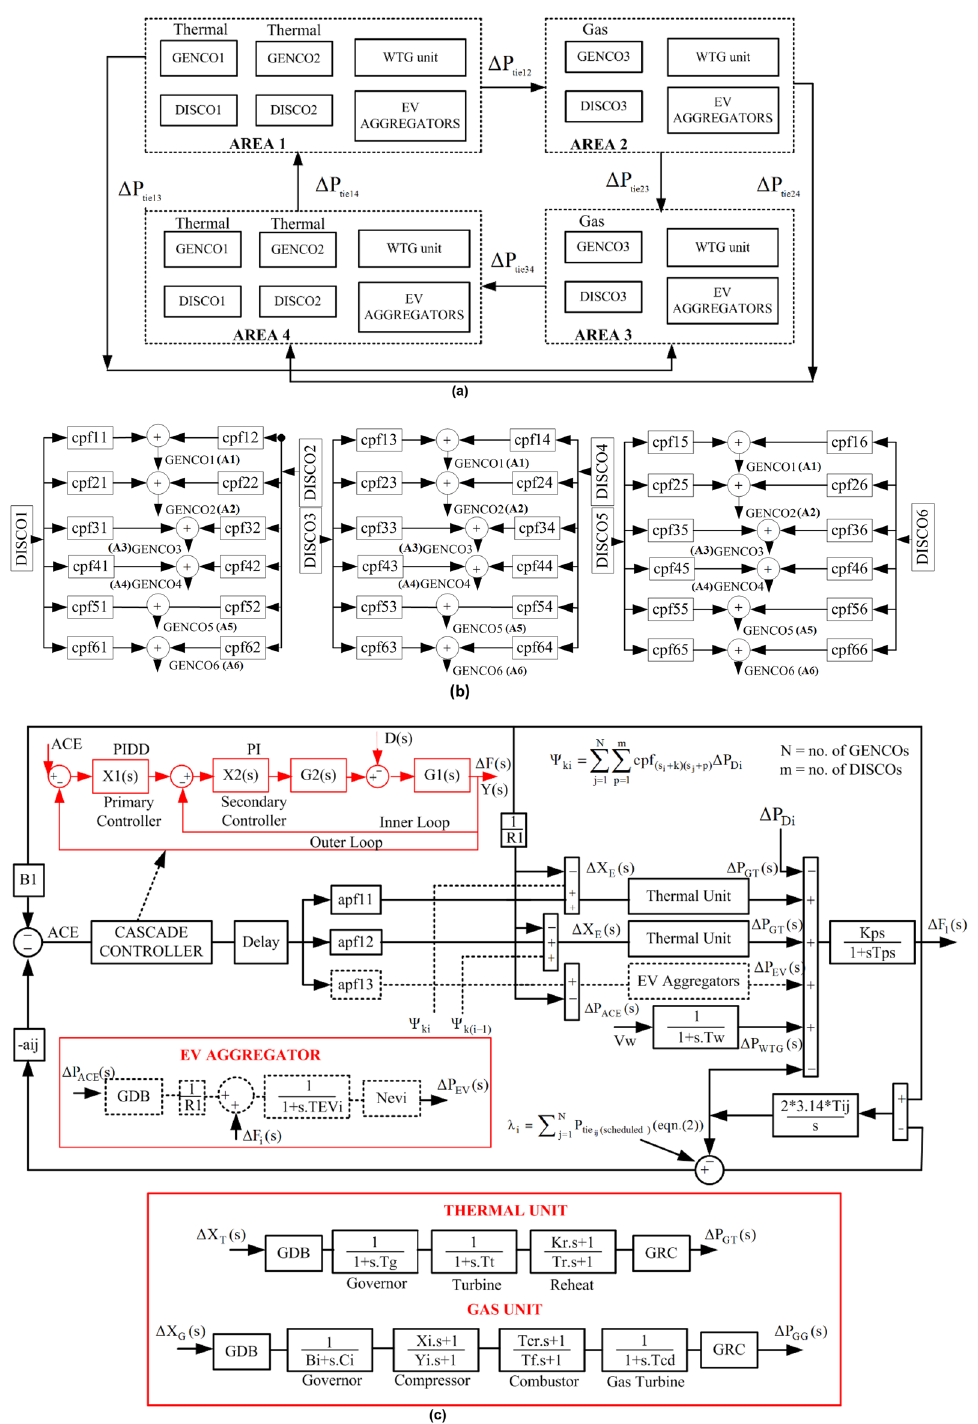
Fig.1 Schematic representation and system layout of the four- area hybrid system under restructured environment. a Schematic diagram of the four-area AGC model. b Description of DISCO participation matrix for the four-area AGC model in restructured environment. c Transfer function model and layout of Area 1 of the hybrid system under restructured environment (incorporating EV and WTG). d Transfer function model of the four area system under Restructured environment (without EV and